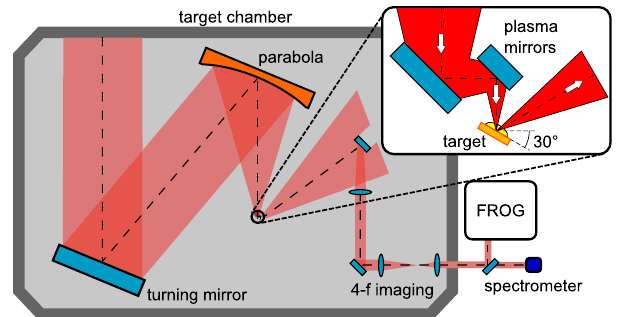
Fig. 6 Schematic experimental setup at the PHELIX laser. The focused laser is re fl ected by both plasma mirrors and interacts with the solid target at an incidence angle of 30°. A part of the re fl ected pulse is blocked by an aperture to reduce the fl uence on the following optics. Therefore only the central part of the beam is collimated and imaged onto a FROG device.